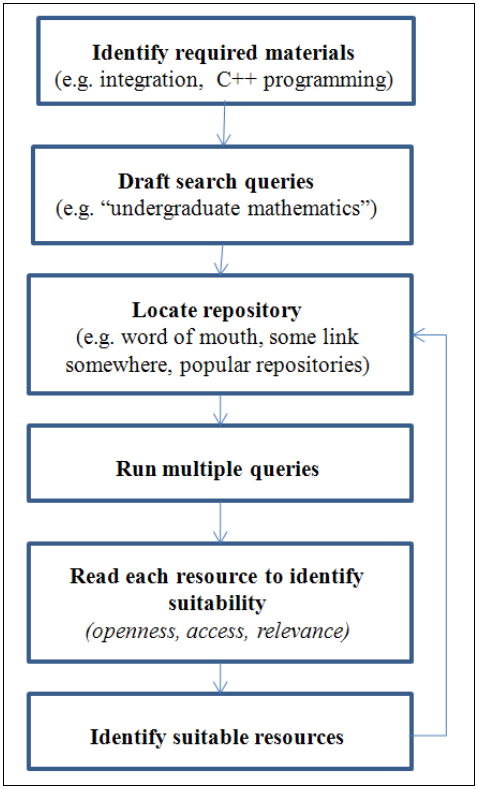
Figure 1 . The flow of activities in searching for suitable OER on heterogenous repositories based on personal experience (Abeywardena, 2013). These activities will need to be repeated on multiple repositories until the required resources are located.